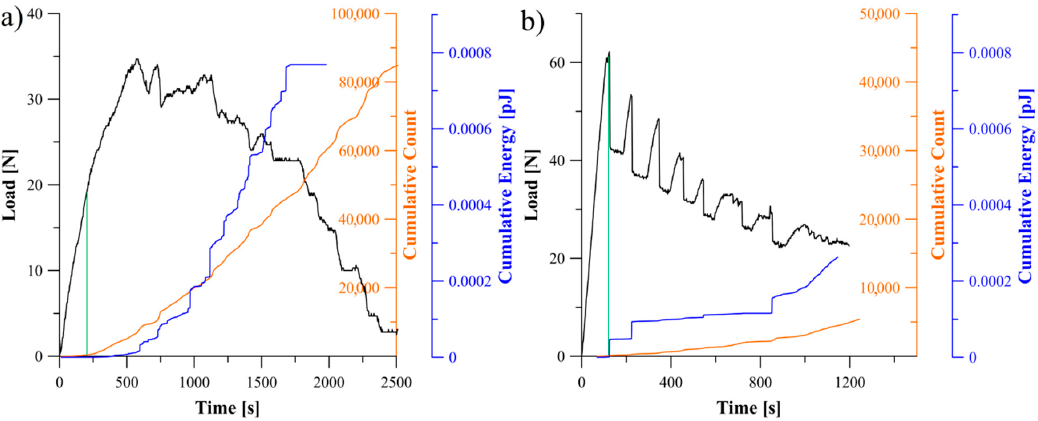
Figure 6. Relation between load, cumulative count and energy of AE signal obtained during the DCB experiment: ( a ) for specimen exhibiting the bending-extension elastic coupling, ( b ) for specimen with 30°//30° delamination interface.